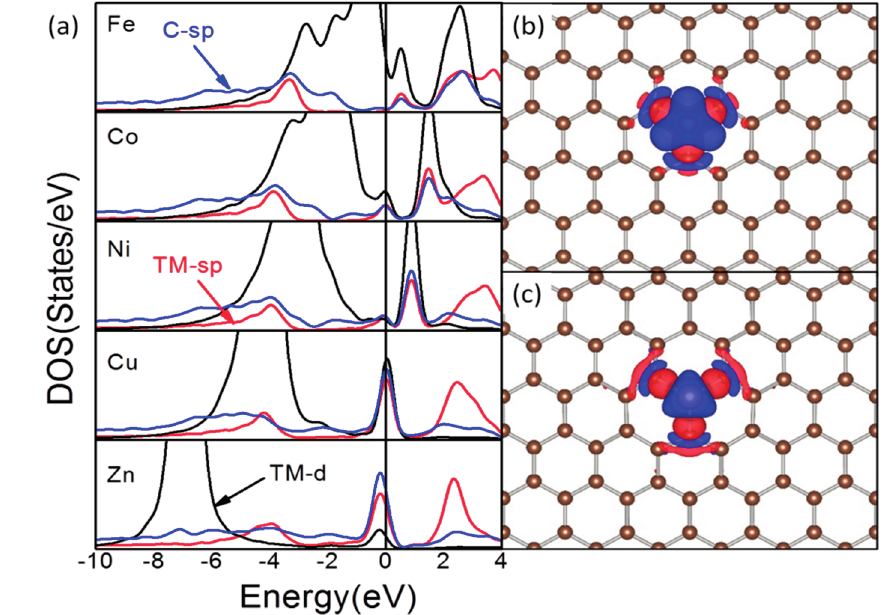
Figure 2. Density of states curves for TM-MG composites ( a ) and contour plots of differential charge density for Fe-MG ( b ) and Zn-MG ( c ) composites. In ( a ), the DOS curves of TM-d, TM-sp and C-sp states are in black, red and blue, respectively. The DOS curves are aligned with the calculated Fermi level (E F ) which is set to zero. In ( b , c ), the contour value is ±3 × 10 − 7 a.u. The charge accumulation regions are in red and the charge depletion regions are in